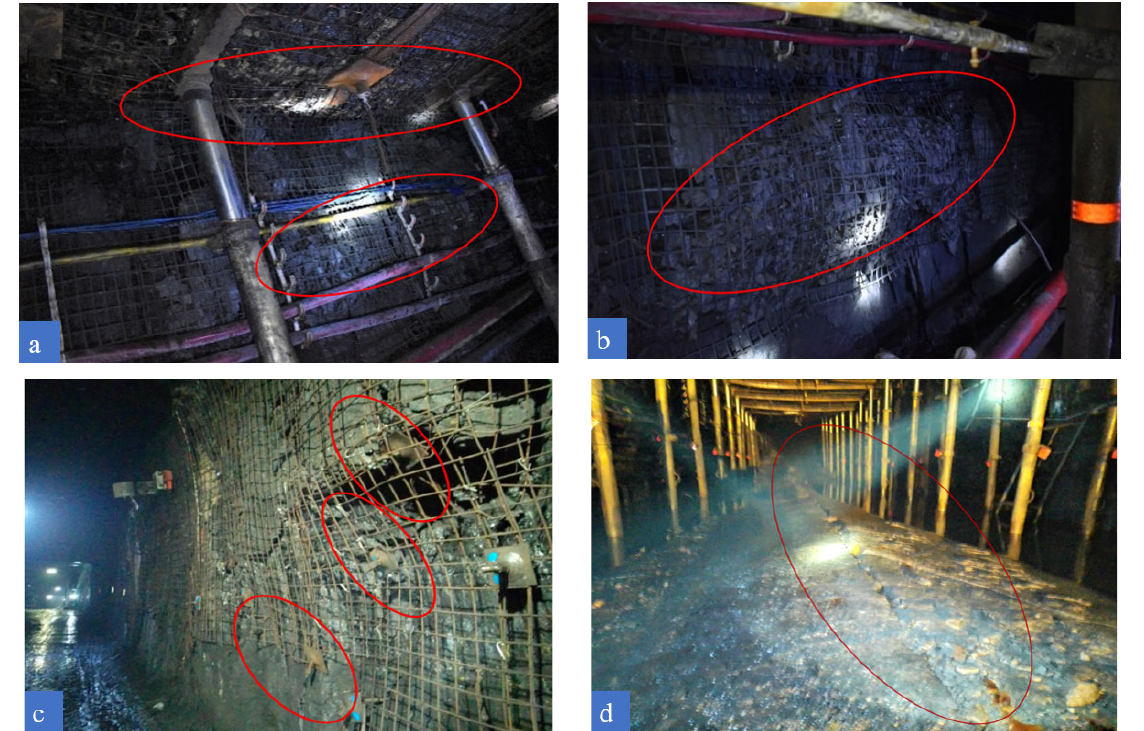
Figure 5. Failure characteristics of a strong mining roadway in RAR 23204: ( a ) stepped roof subsidence and mining sidewall failure; ( b ) failure instability of mining sidewall; ( c ) pillar sidewall failure instability and bolt failure; ( d ) severe floor heaving and floor cracking.